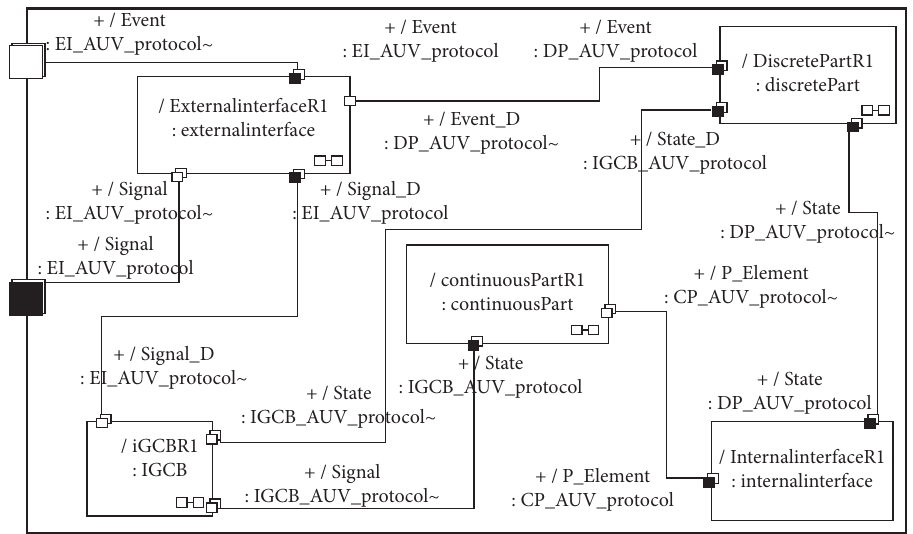
Figure 5: Capsules’ collaboration of the real-time communication pattern for the AUV